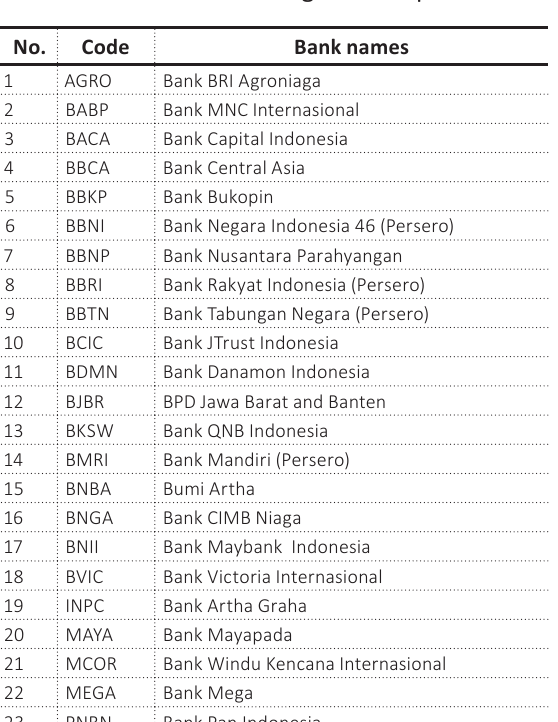
Table 2. Bank names serving as a